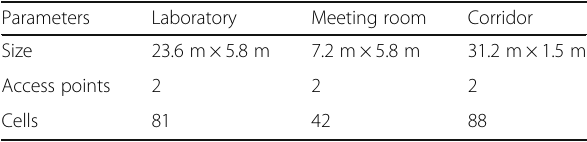
Table 1 Main parameters of the scenarios Parameters